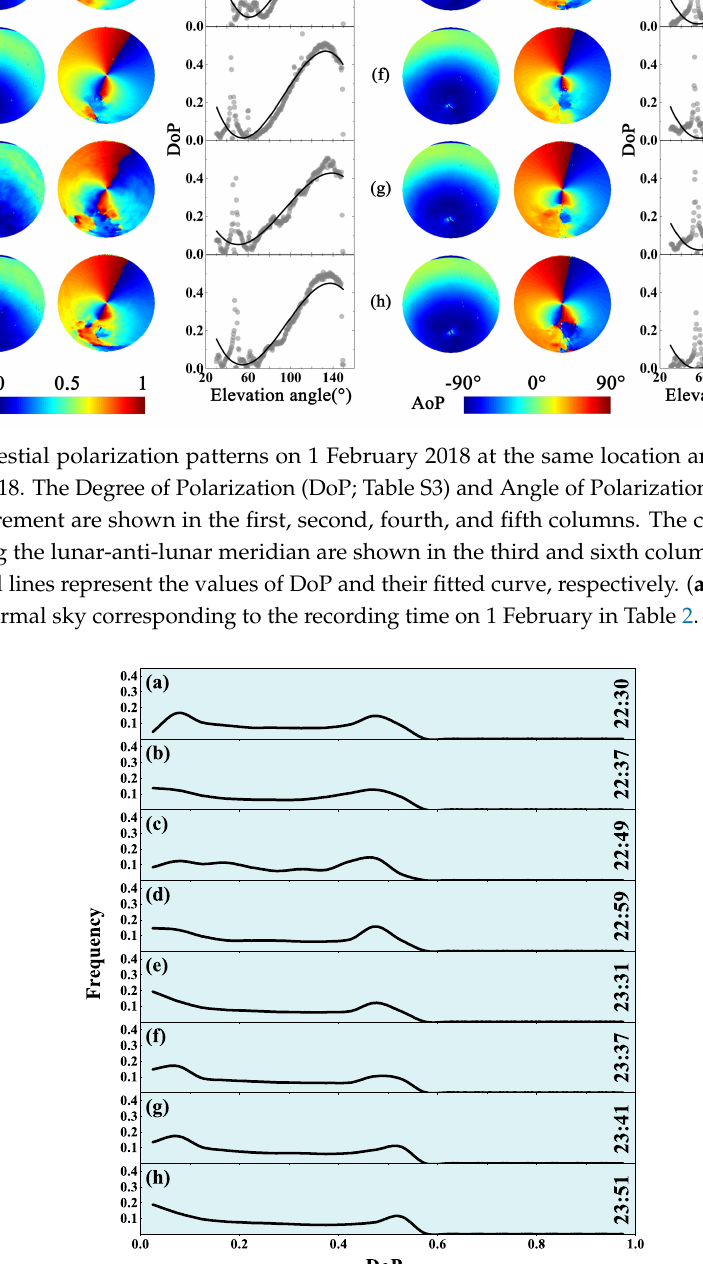
Figure 5. Frequency change of the Degree of Polarization (DoP) during the normal sky. ( a – h ) Frequency of DoP in normal sky corresponding to the recording time on 1 February in Table 2. The time shown above is Local Time